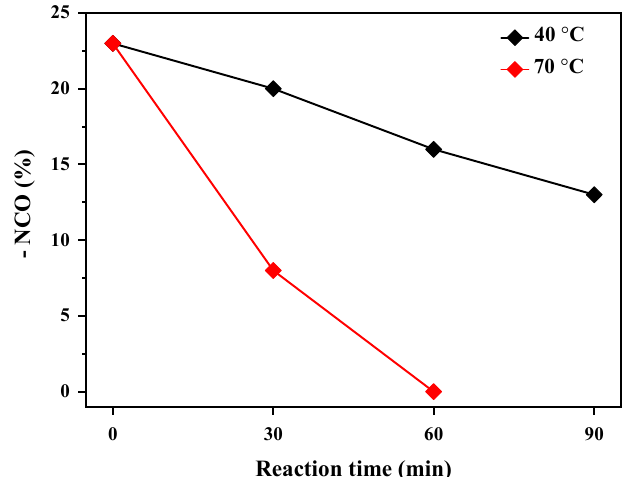
Figure 6. Changes in –NCO group content with the reaction of the urethane prepolymer and DMP.